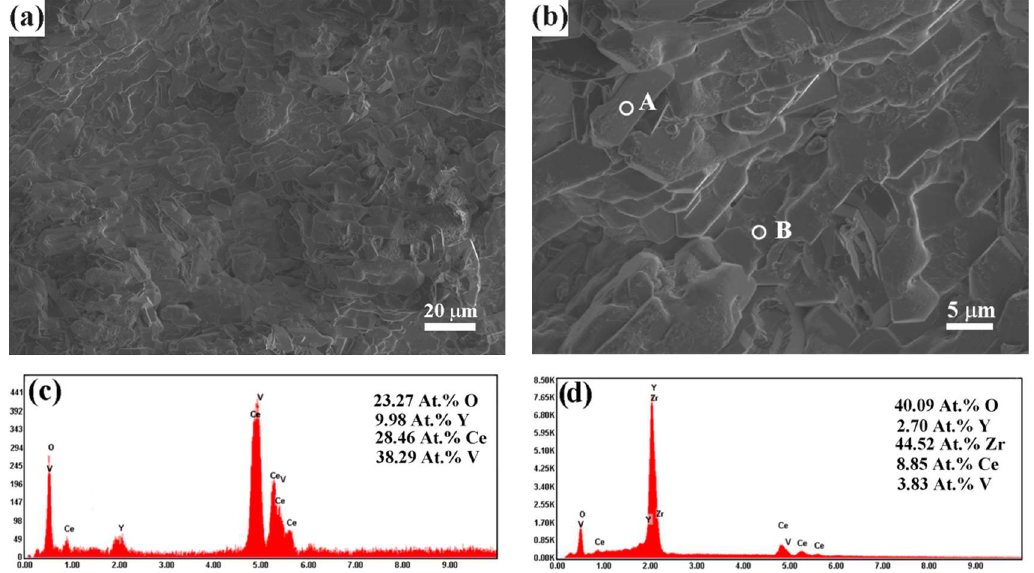
Figure 10. The SEM surface morphology of the plasma-sprayed coating after the hot corrosion test: ( a ) lower magnification; ( b ) higher magnification of image ( a ). EDS analysis of ( c ) Spot A and ( d ) Spot B.